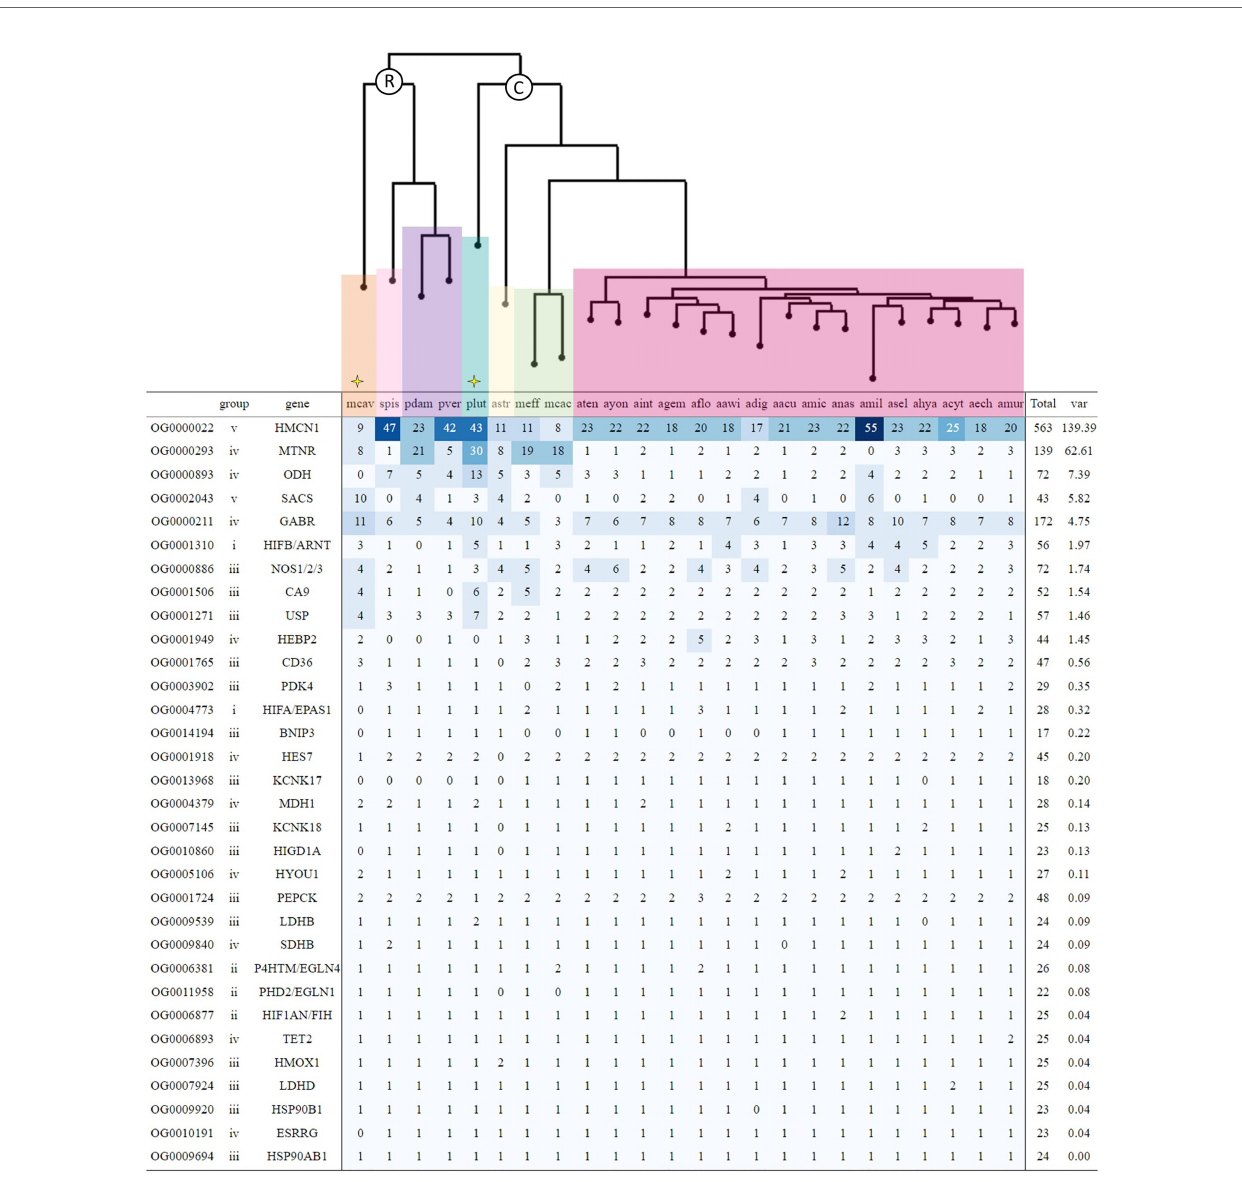
FIGURE 2 | Gene count heatmap table for coral hypoxia genes of interest (GOIs) across 24 coral genomic gene sets ordered by descending variance. The fi rst column denotes the orthogroups that OrthoFinder assigned each gene. Types of genes are grouped according to categories i-v as referred to in Table 2 . For genes that had multiple orthogroups, the heatmap details only the orthogroup with the highest variance (see Tables S4 – S7 for heatmap tables showing all orthogroups for GOIs with unequal expansion across species). Coral species are grouped according to taxonomy, with R and C indicating Robust and Complex clade species, respectively. Yellow stars fl ag those coral species that have been reported as more stress-tolerant. Colour gradient from light to dark blue represents increasing variance. Refer to Table 1 for the corresponding full species